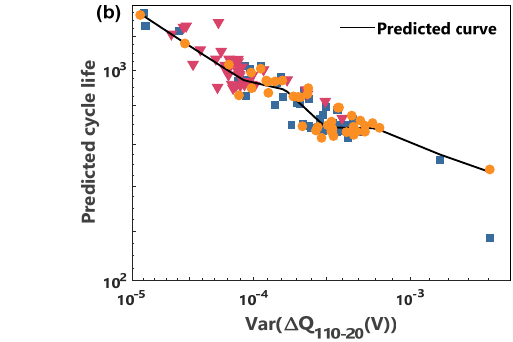
Figure 6. RBFNN and power characteristic model cycle life prediction. ( a ) Comparison of observed life and predicted life, ( b ) the cycle life predicted curve.